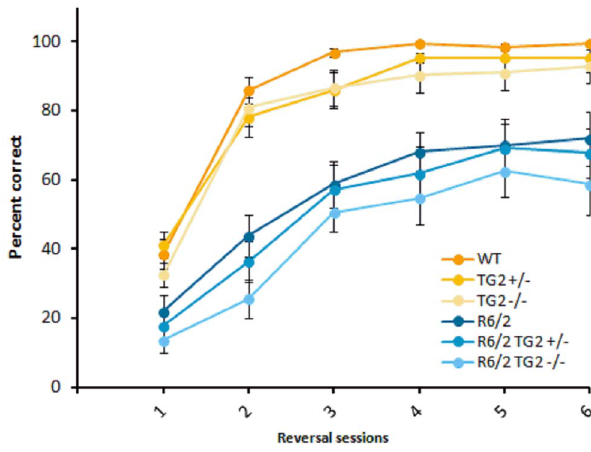
Figure 6. Reversal phase of the procedural T–maze task (platform location switched; n=19–24 per genotype). The graph shows the mean ( 6 SEM) percent correct for each group, on each test day. WT: wild-type, TG2 + / 2 : heterozygous TG2 knockout, TG2 2 / 2 : homozygous TG2 knockout.